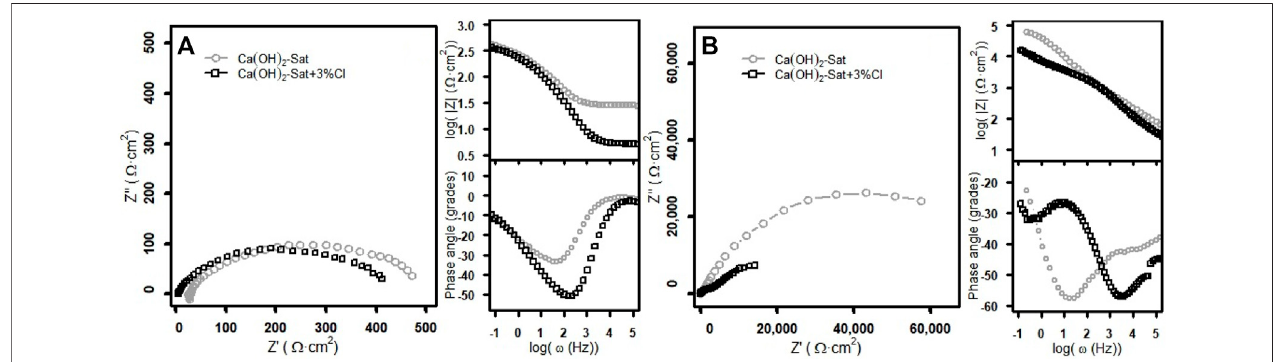
FIGURE 5 | EIS spectra of zinc plates in the two test solutions: (A) before the sudden rise in the E corr and (B) after the sudden rise in the E corr .